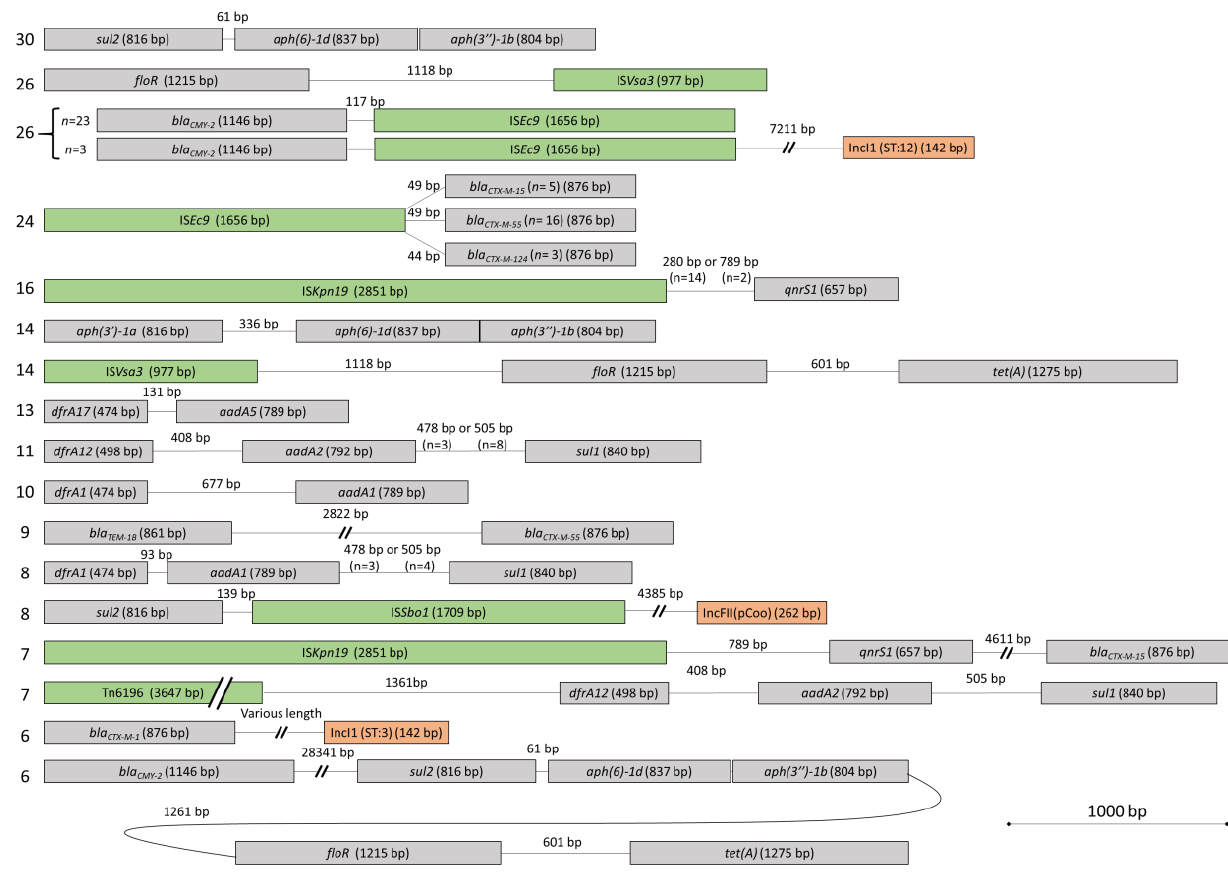
Figure 2. Fixed contiguous resistance genes and mobile genetic elements found with ResFinder, PointFinder, PlasmidFinder, and MGE finder from the Center for Genomic Epidemiology platform for a selection of the most resistant Escherichia coli ( n = 118) isolated from manure from 101 dairy farms in Québec, Canada. Only isolates of which six or more harbour the resistance gene and mobile genetic element are represented in the figure.